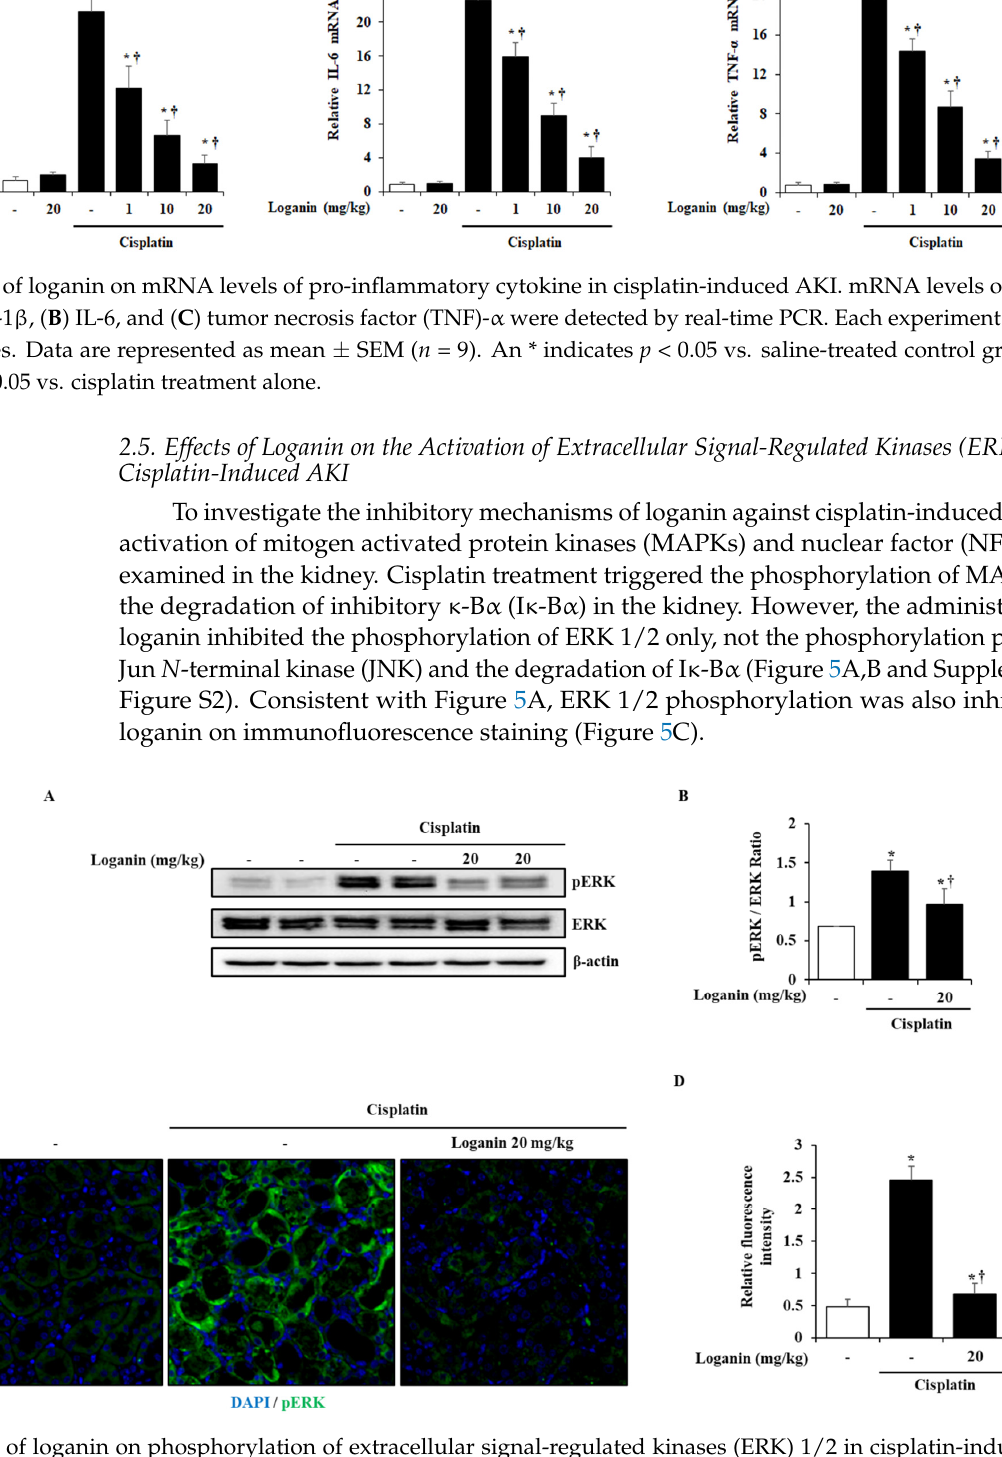
Figure 5. Effect of loganin on phosphorylation of extracellular signal-regulated kinases (ERK) 1/2 in cisplatin-induced AKI. ( A ) The phosphorylation of ERK 1/2 was analyzed by Western blot. Total ERK1/2, and β -actin were used as loading controls. ( B ) The relative density ratio of pERK1/2/ERK1/2. ( C ) Representative pERK1/2-stained sections of the kidney (200 × magnification). ( D ) pERK1/2-positive areas of the kidney were scored for green fluorescence. Each experiment was repeated 3 times. Data are represented as mean ± SEM ( n = 9). An * indicates p < 0.05 vs. saline-treated control group; † indicates p < 0.05 vs. cisplatin treatment alone. Scale bar = 20 µ